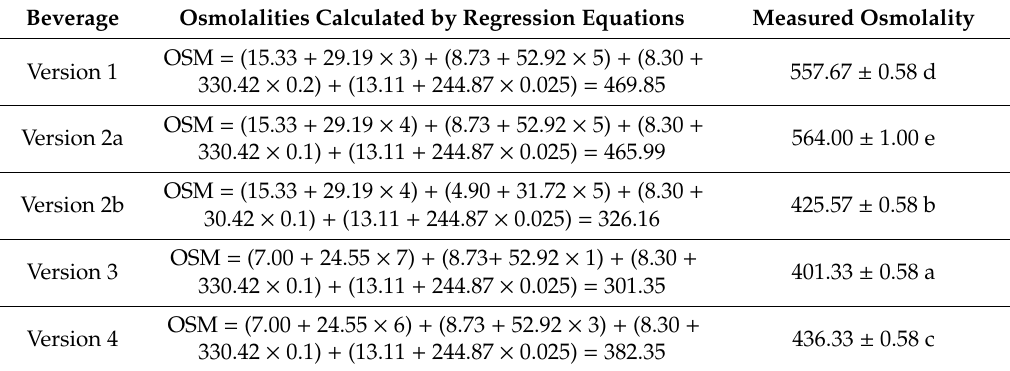
Table 2. Osmolalities of designed beverages.